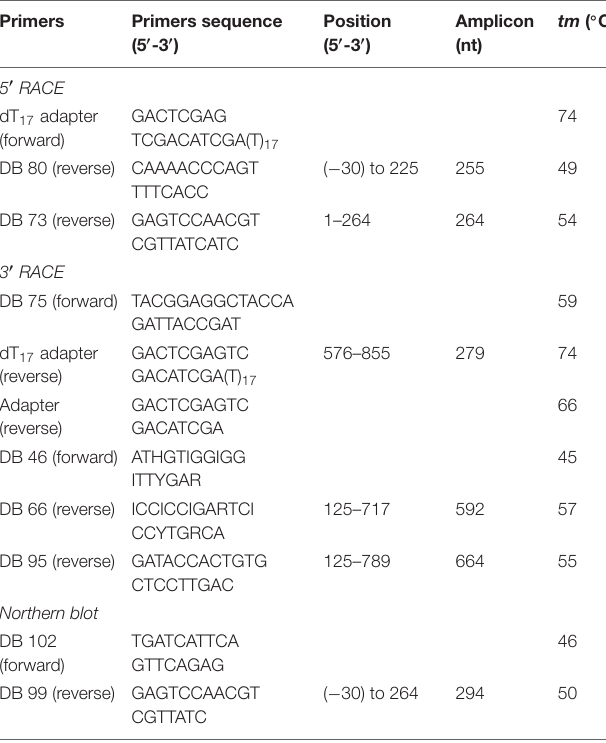
TABLE 1 | Primers used in sequencing and Northern blot analysis of Culex quinquefasciatus late trypsin transcript.